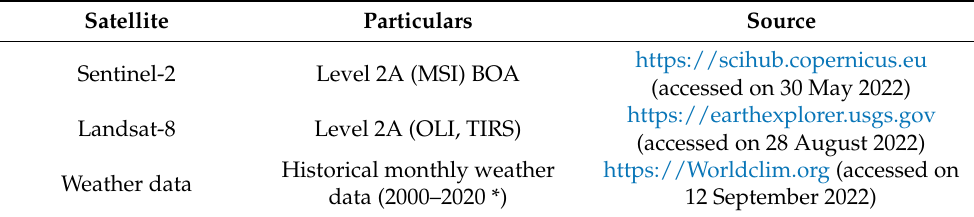
Table 2. Summary of satellite and source